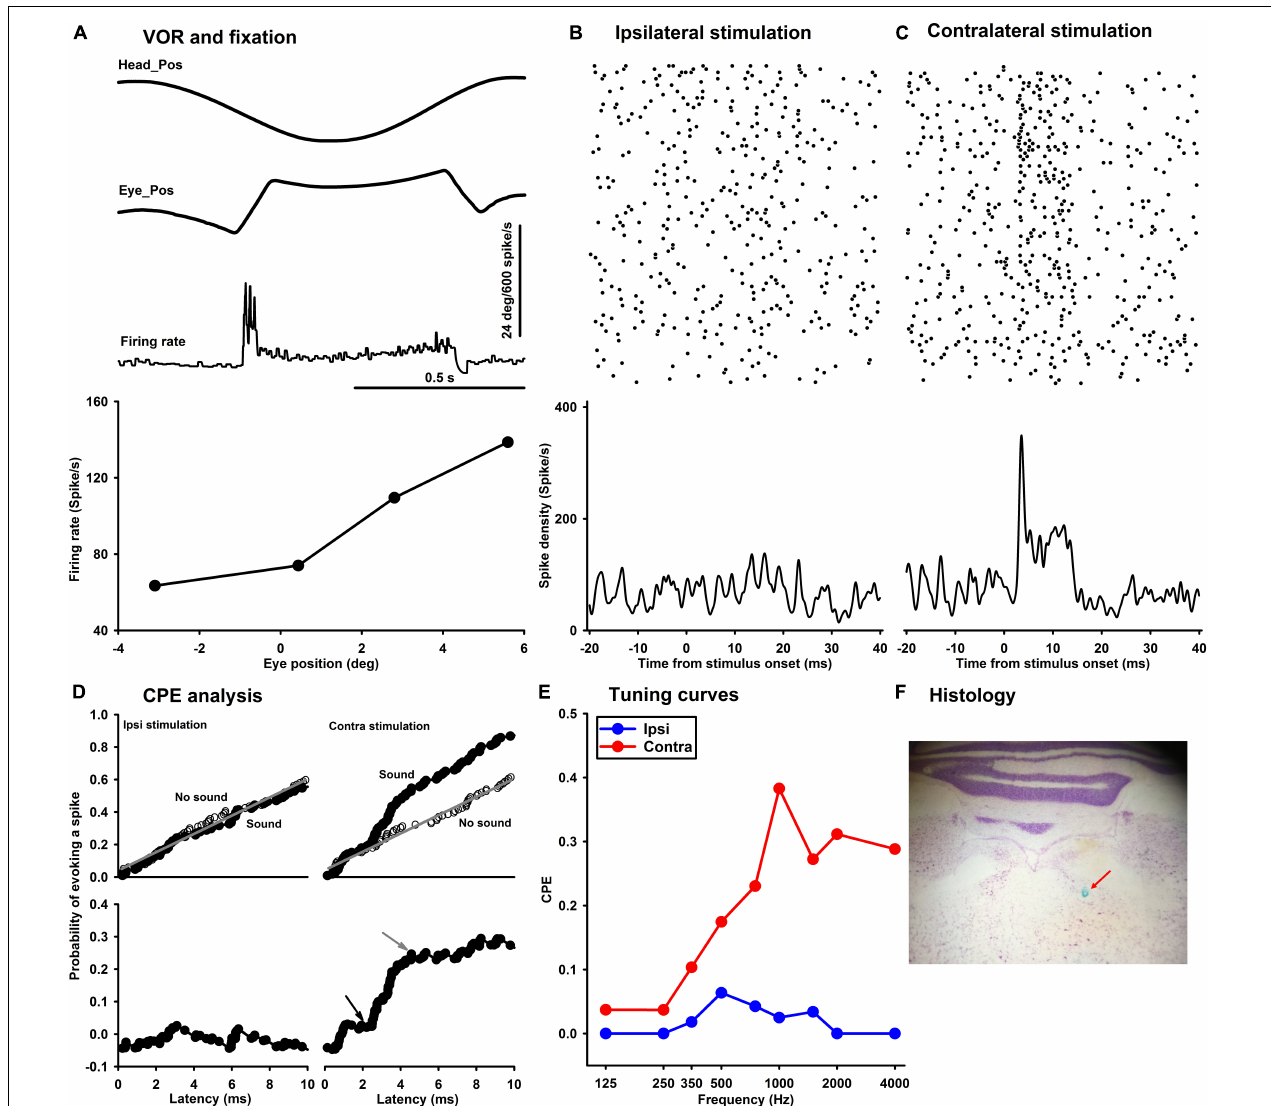
FIGURE 7 | Sound-evoked responses in a representative abducens neuron in an awake rat. (A) Discharge activities during eye movements in response to head rotation ( A , top and middle panels) and fixations ( A , lower panel). Raster of the abducens neuron in response to 1,000 Hz tone bursts delivered into the ipsilateral ear (B) or the contralateral ear (C) . (D) CPE analysis of tone-evoked responses in the abducens neuron. (E) Tuning curves of the abducens neurons for ipsilateral (blue) and contralateral (red) ear stimulation. (F) Histological verification of a recording site in the abducens